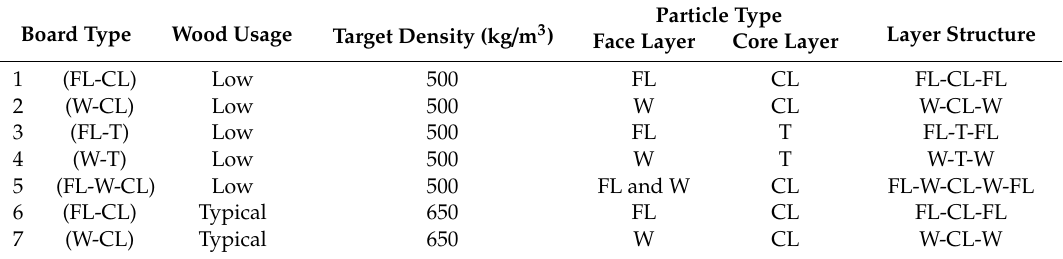
Table 2. Definition of board types in respect to wood usage and, thus, target density, and particle type in face and core layer. Including; plant-made face layer particle (FL), plant-made core layer particle of typical thickness (CL), wafer (W), and lab-made core layer particle of intentionally greater thickness